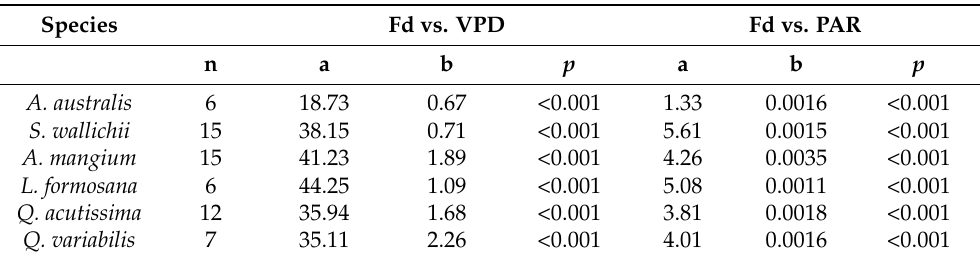
Table 6. Parameters for the Exponential Saturation Model Fd = a (1 − exp − b x ) for six species, where a and b are the fitted